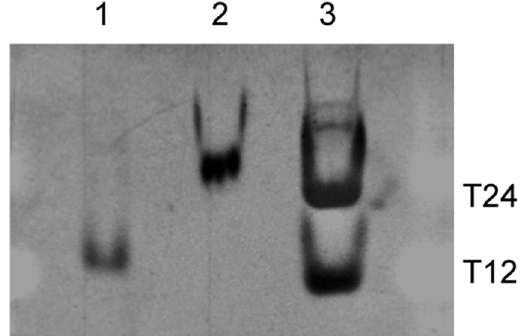
Figure 6. Nondenaturing gel electrophoresis of ORN-2. Lane 1: native 6 nt r(UAGGGU) as a control, lane 2: ORN-2, lane 3: markers dT12 and